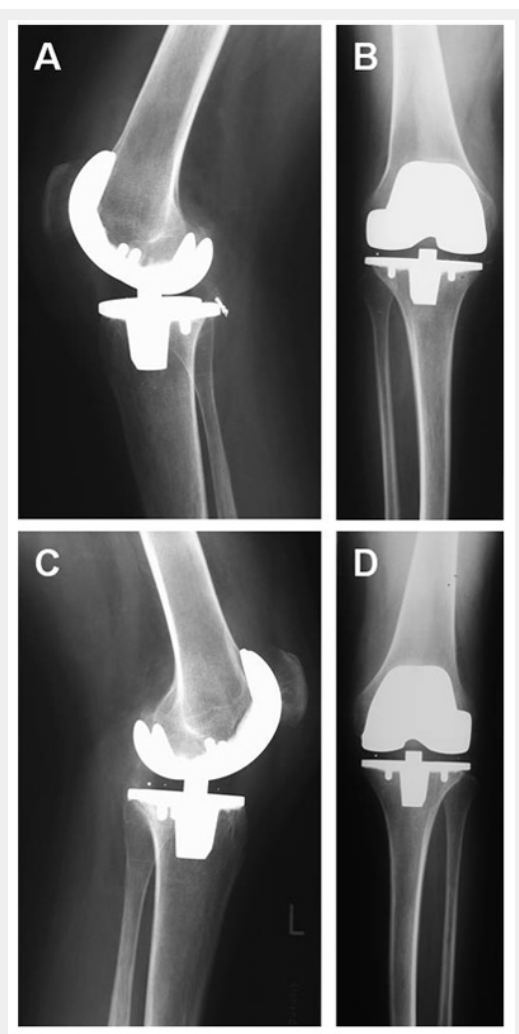
lateral view (b) Right knee anterior-posterior view (c) Left knee lateral view (d) Left knee anterior-posterior